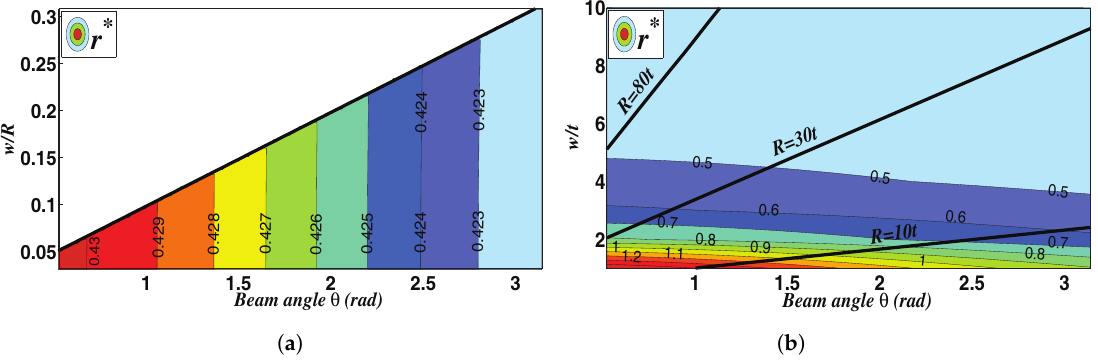
Figure 5. The influence of geometric parameters on the dimensionless ratio r ∗ : ( a ) influence of varying w / R and θ for w / t = 10, ( b ) influence of varying of w / t and θ . The inclined straight lines represent the limit space of admissible geometries employing the slender beam